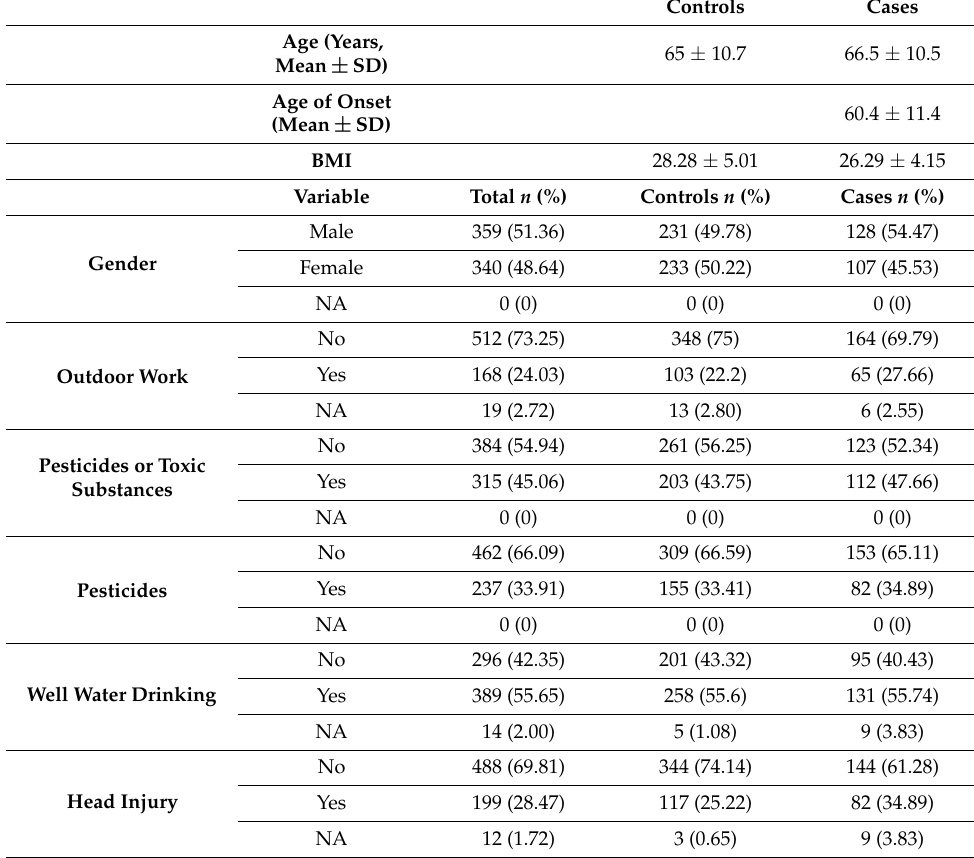
Table 2. Demographic characteristics and lifestyle/environmental risk factors of Cypriot PD cases and controls before